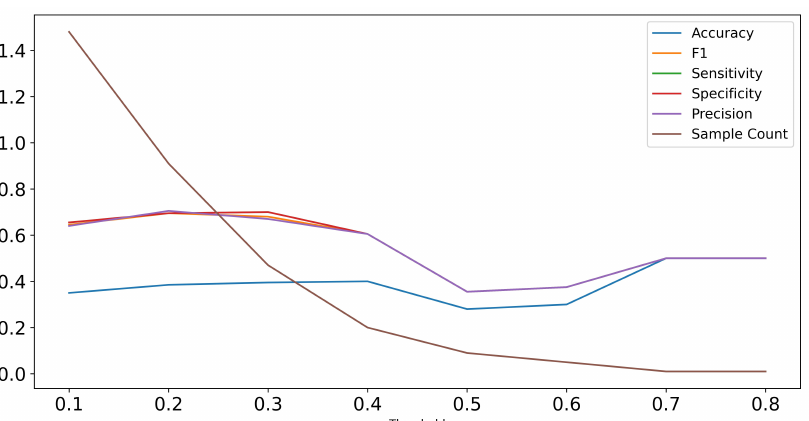
Figure A2. Performance of Random Forest classifier on test set predictions with increasing thresholds in terms of F1-score, sensitivity, specificity, and precision. The sample count visualizes that with higher threshold, the number of samples included in the test set decreases as the Random Forest is only applicable to samples with detected